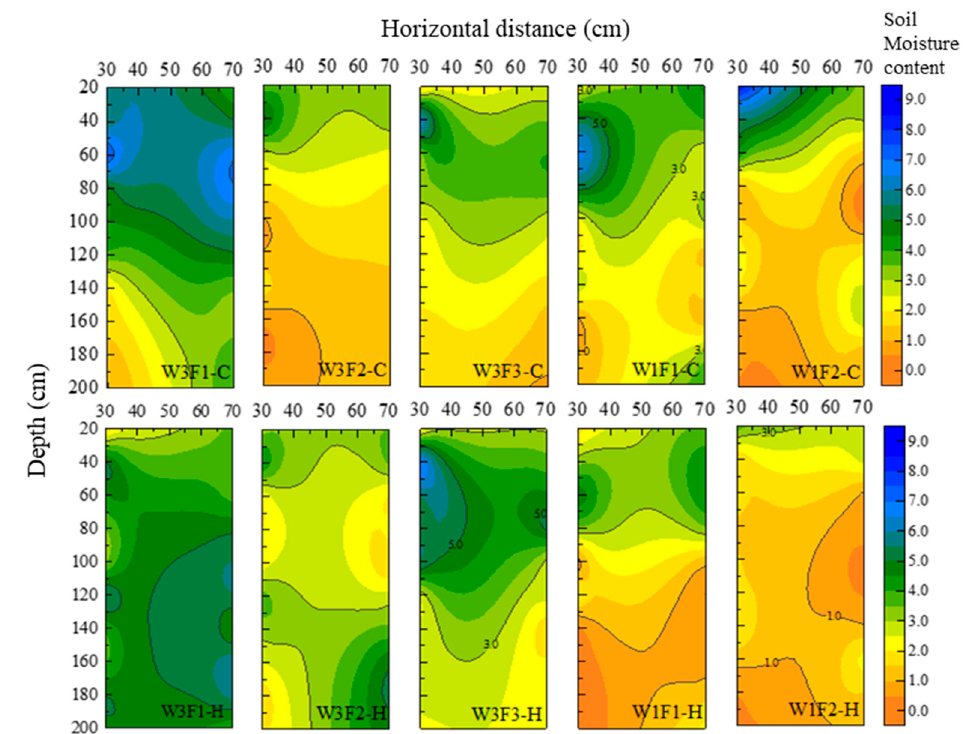
Figure 4. Spatial variation in soil moisture content under different irrigation periods. The soil moisture content in the low (W1), medium (W2), and high (W3) irrigation amounts. F means irrigation frequency with F1 = 10 d, F2 = 20 d, F3 = 40 d. C and H represent C. mongolicum and H. ammodendron , respectively.